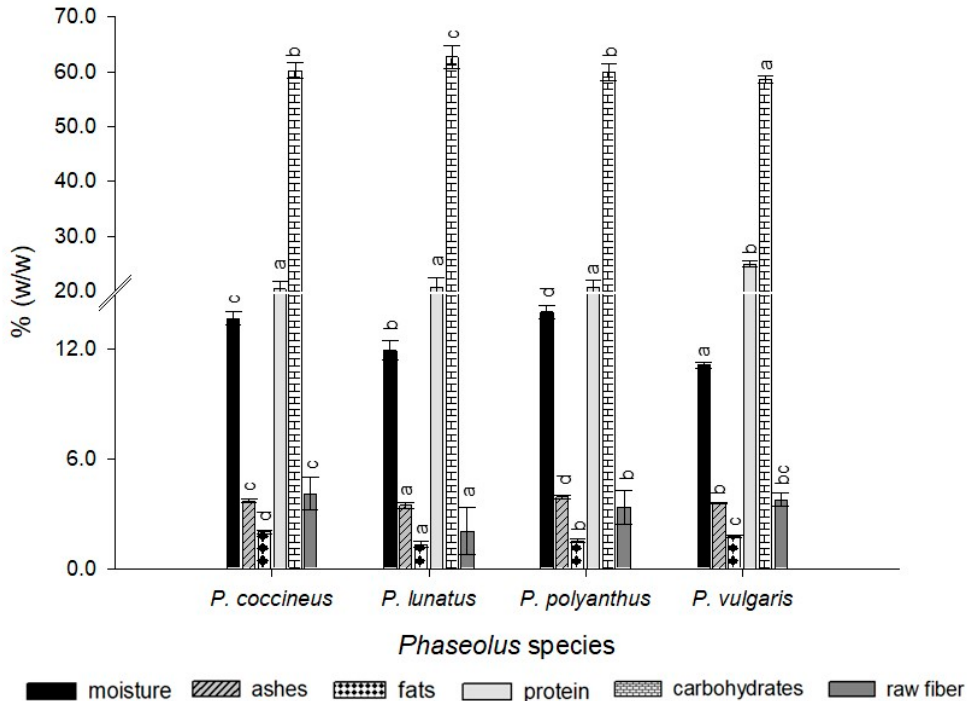
Figure 1. Proximate composition of bean varieties by Phaseolus species. Mean values ± standard deviation (SD). Different letters indicate statistically significant differences according to Tukey’s test ( p < 0.05).